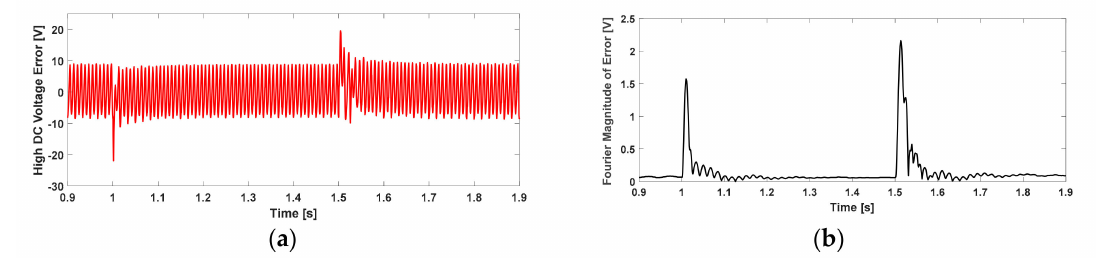
Figure 7. Error signal characteristics during fault-free operation: ( a ) error signal, and ( b ) Fourier